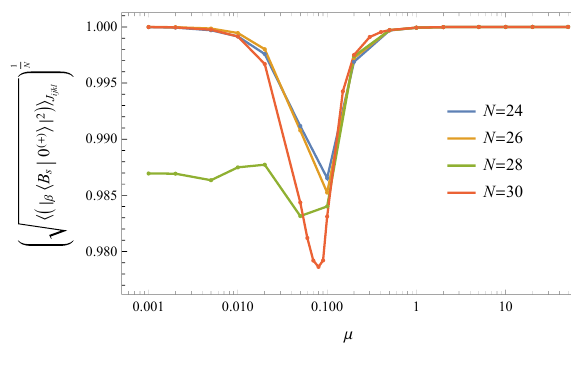
(cid:16)q (cid:17) 1 N , with the horizontal 2 B 0 (+) ( ; ; ; ) j hj (cid:12) h ij i J ijk‘ # # (cid:1)(cid:1)(cid:1) #